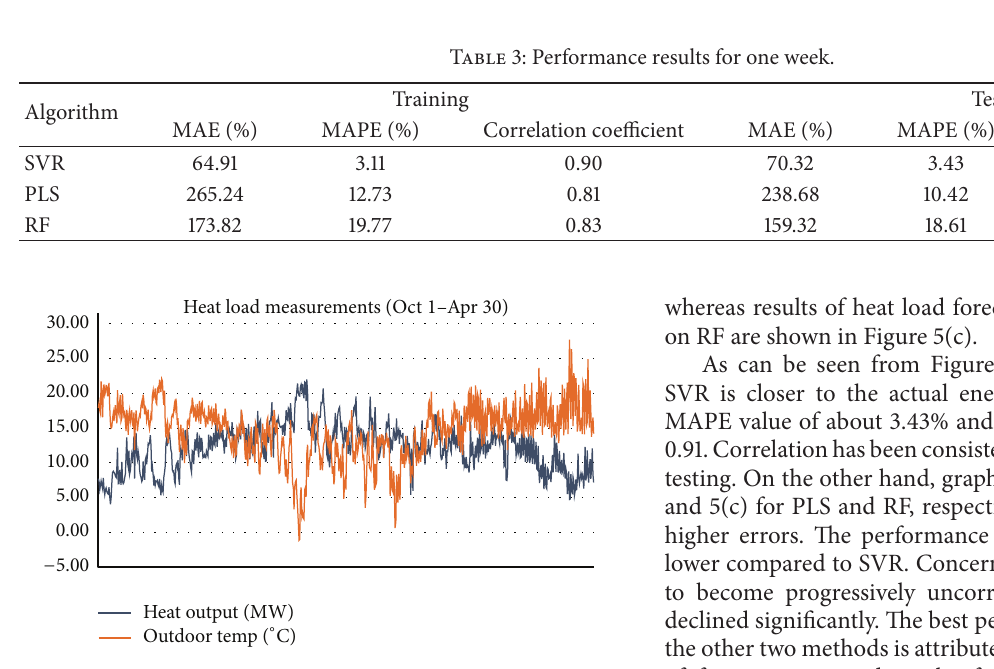
Figure 4: Hourly heat load pattern in relation to outdoor tempera- ture in the DH